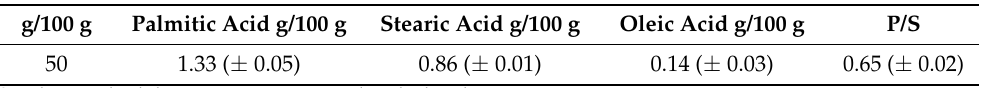
Table 2. Results of absolute quantification of fatty acids in dried yellow ochre and linseed oil mixture (concentration of oil 50 g/100 g) a .